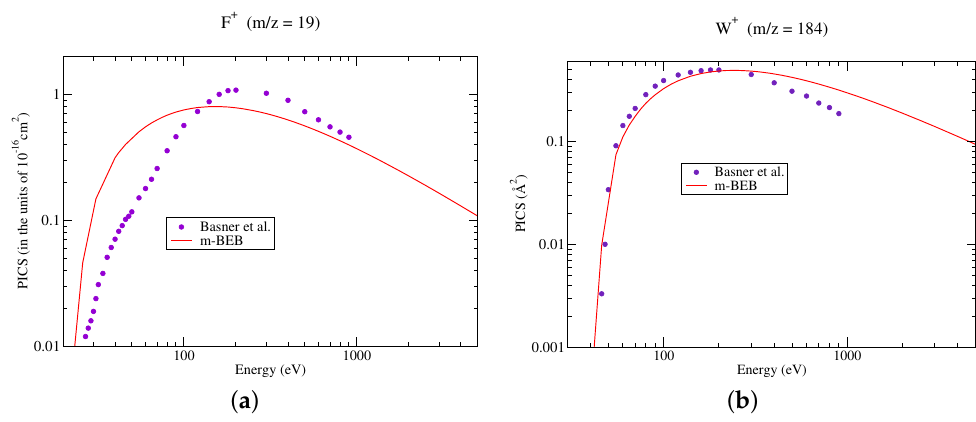
Figure 2. Partial ionization cross sections of SI cations of WF 6 : ( a ) m / z = 19, ( b ) m / z = 184. Line curve, m-BEB results after renormalizing BEB TICS to the sum of SI and DI PICS of Basner et al. [21]; Circles, the sum of SI and DI PICS of Basner et al. [21].